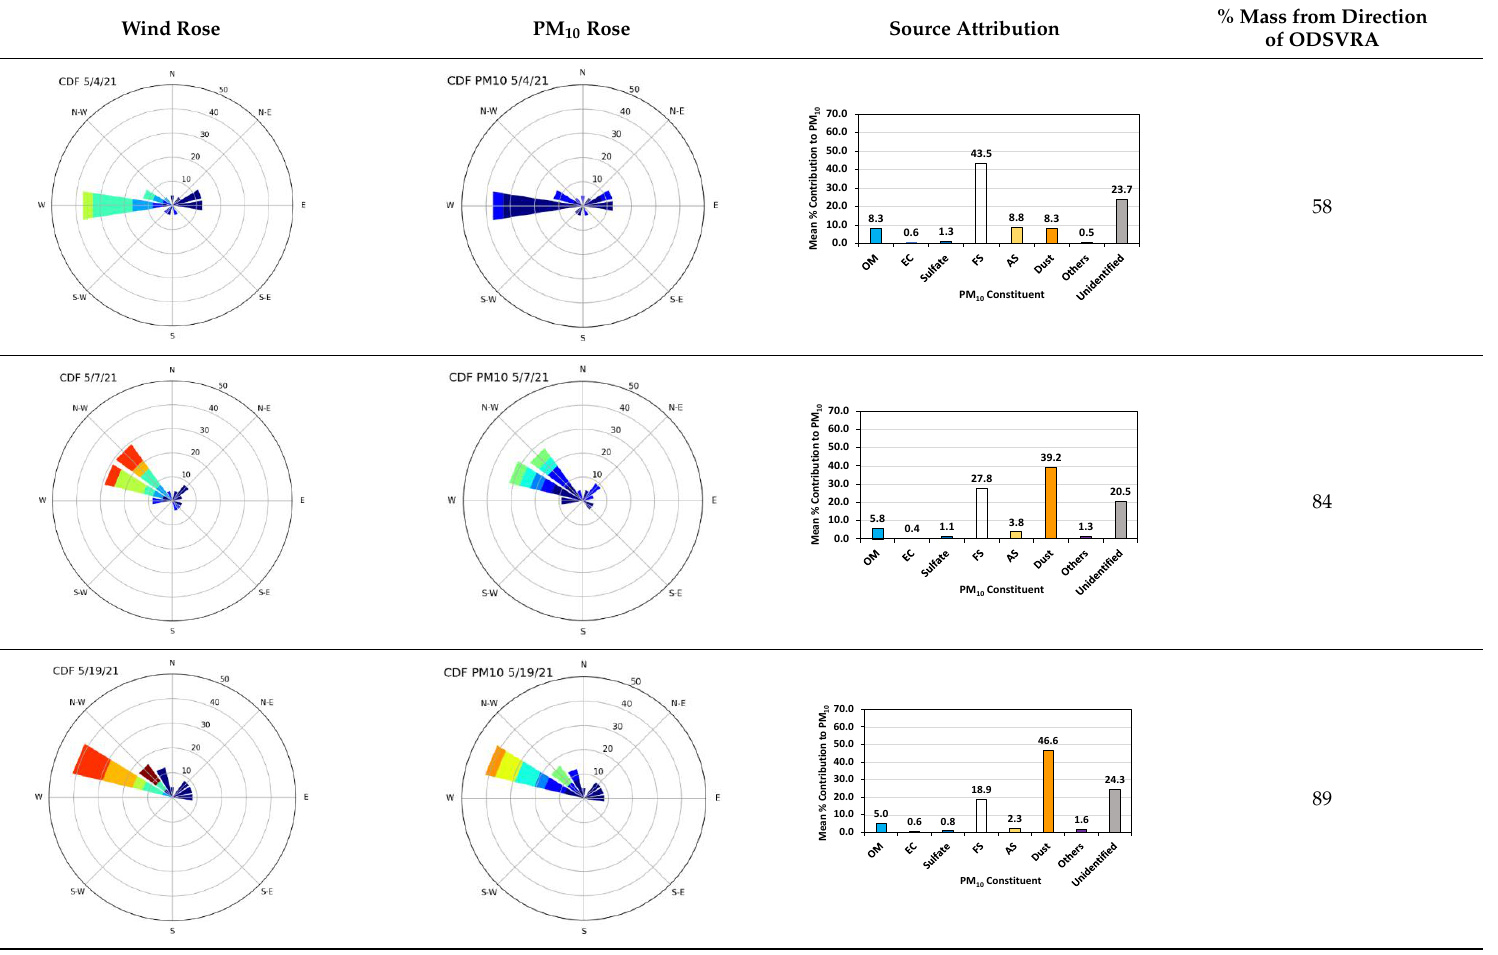
Table 3. Days that exceeded the state 24 h mean PM 10 , wind and PM 10 directional relations, and the attribution of PM 10 mass based on the hours of transport from the direction of the ODSVRA to the CDF.